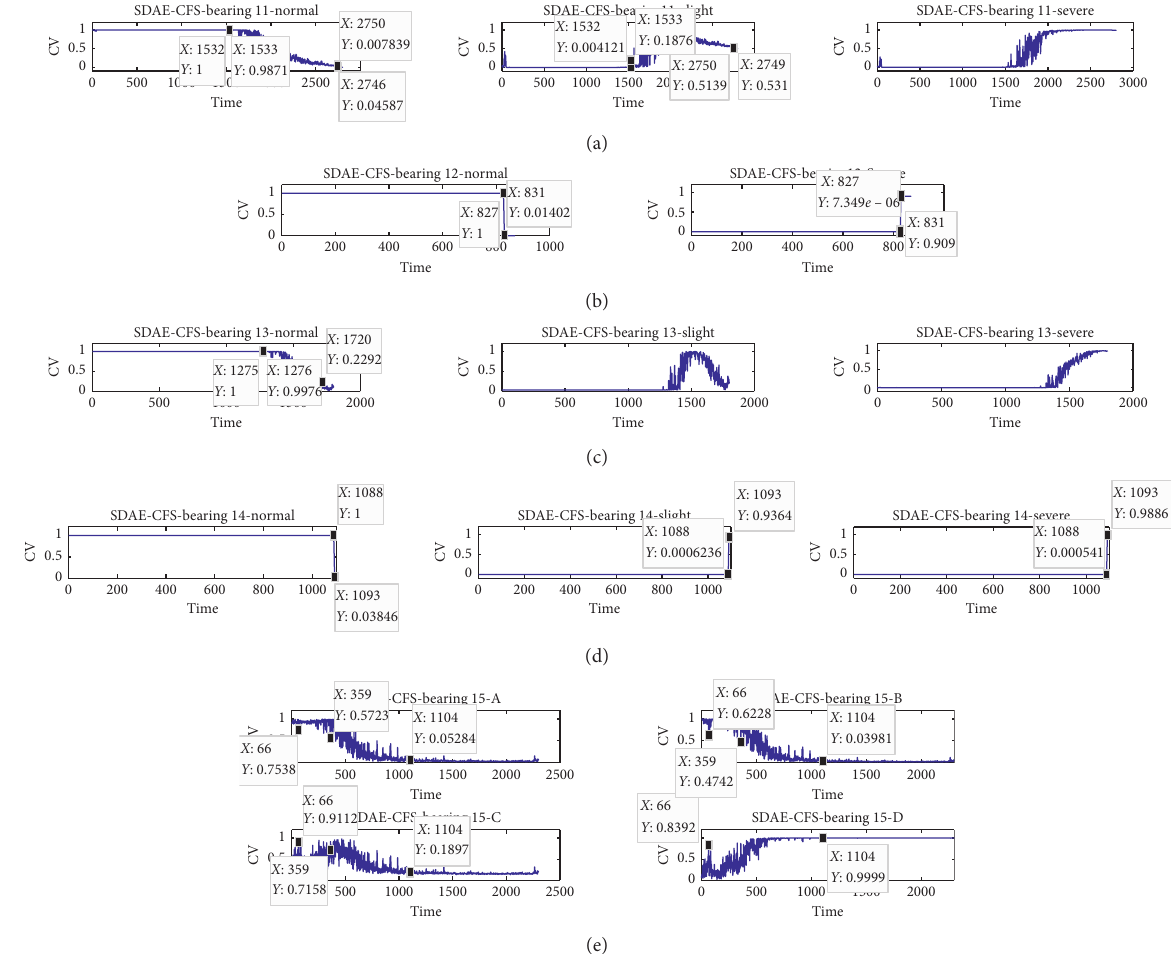
Figure 18: CVs for bearings 11–15 resulting from using the SDAE-CFS under various conditions such as “Normal,” “Slight,” and